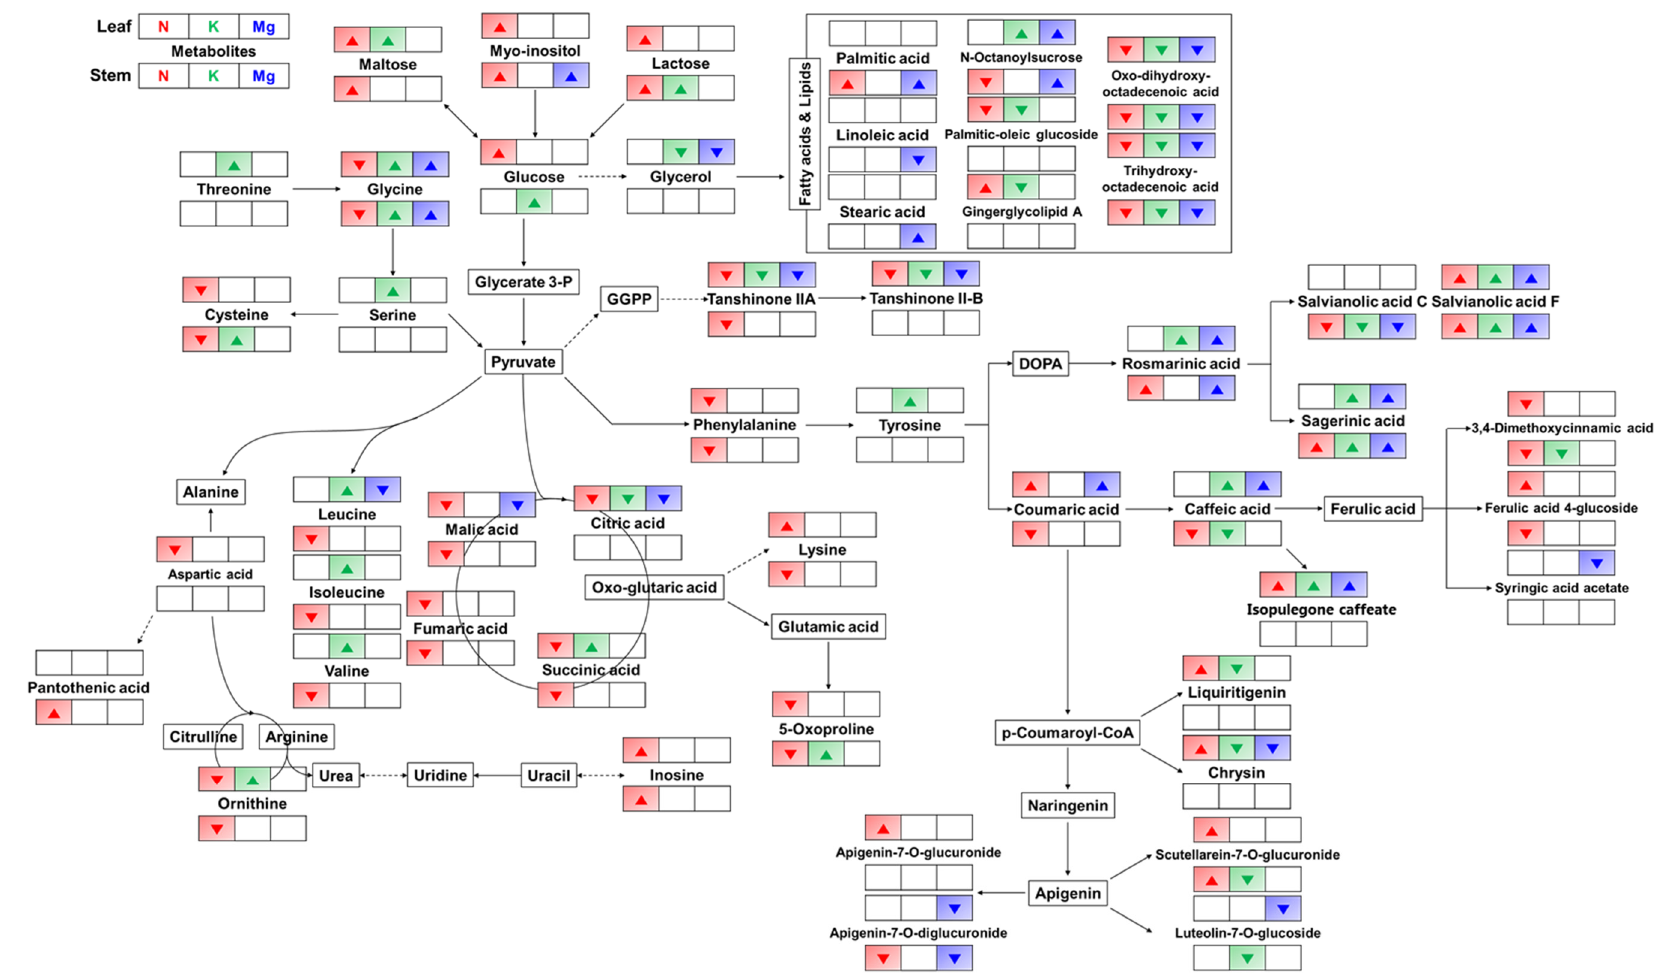
Figure 3. The proposed metabolic pathway under the lowest mineral supply for 21 days in Perilla frutescens . Significantly altered metabolites are represented by up and down arrows for each mineral-deficient condition depending on whether their levels increased or decreased, respectively. The pathway was modified from KEGG (http://www.genome.jp/kegg). N: nitrogen; K: potassium; Mg: magnesium.